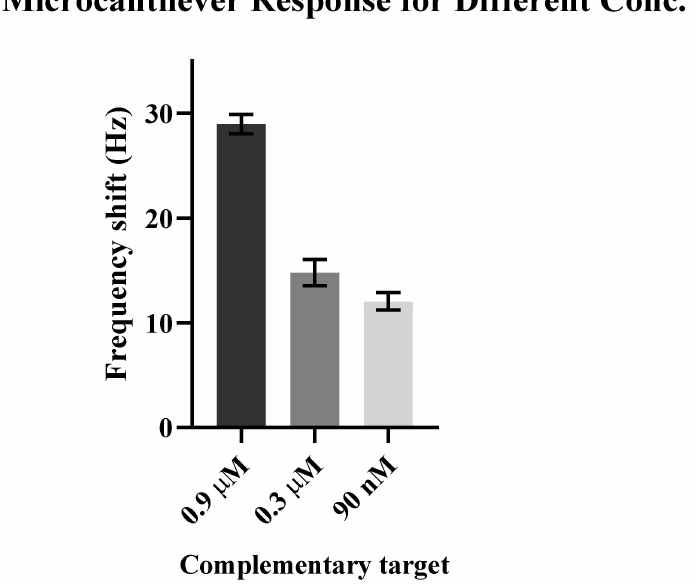
Figure 5. The resonance frequency shift of immobilized microcantilever in response to different concentrations of complementary target DNA. The high concentration induces a large frequency